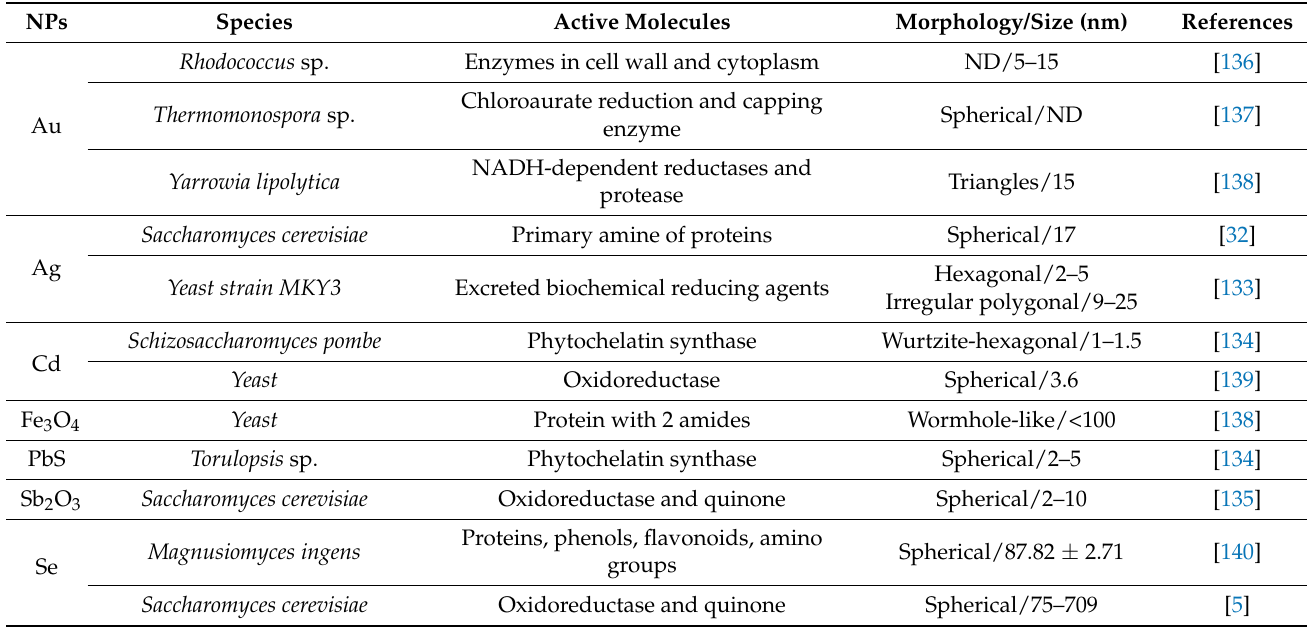
Table 2. Nanoparticles produced by Actinomycetes and